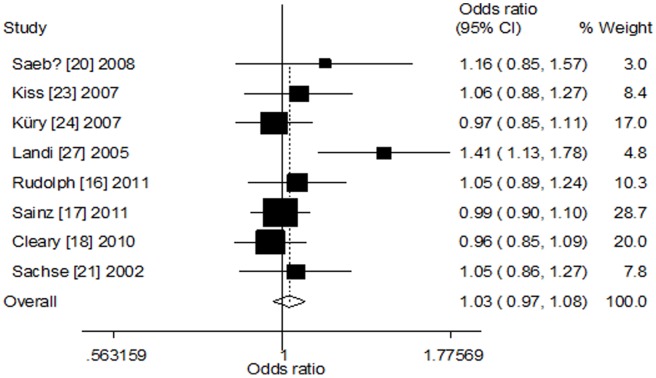
Forest plot of CYP1A2*F polymorphism and colorectal cancer risk among Caucasians (additive model).